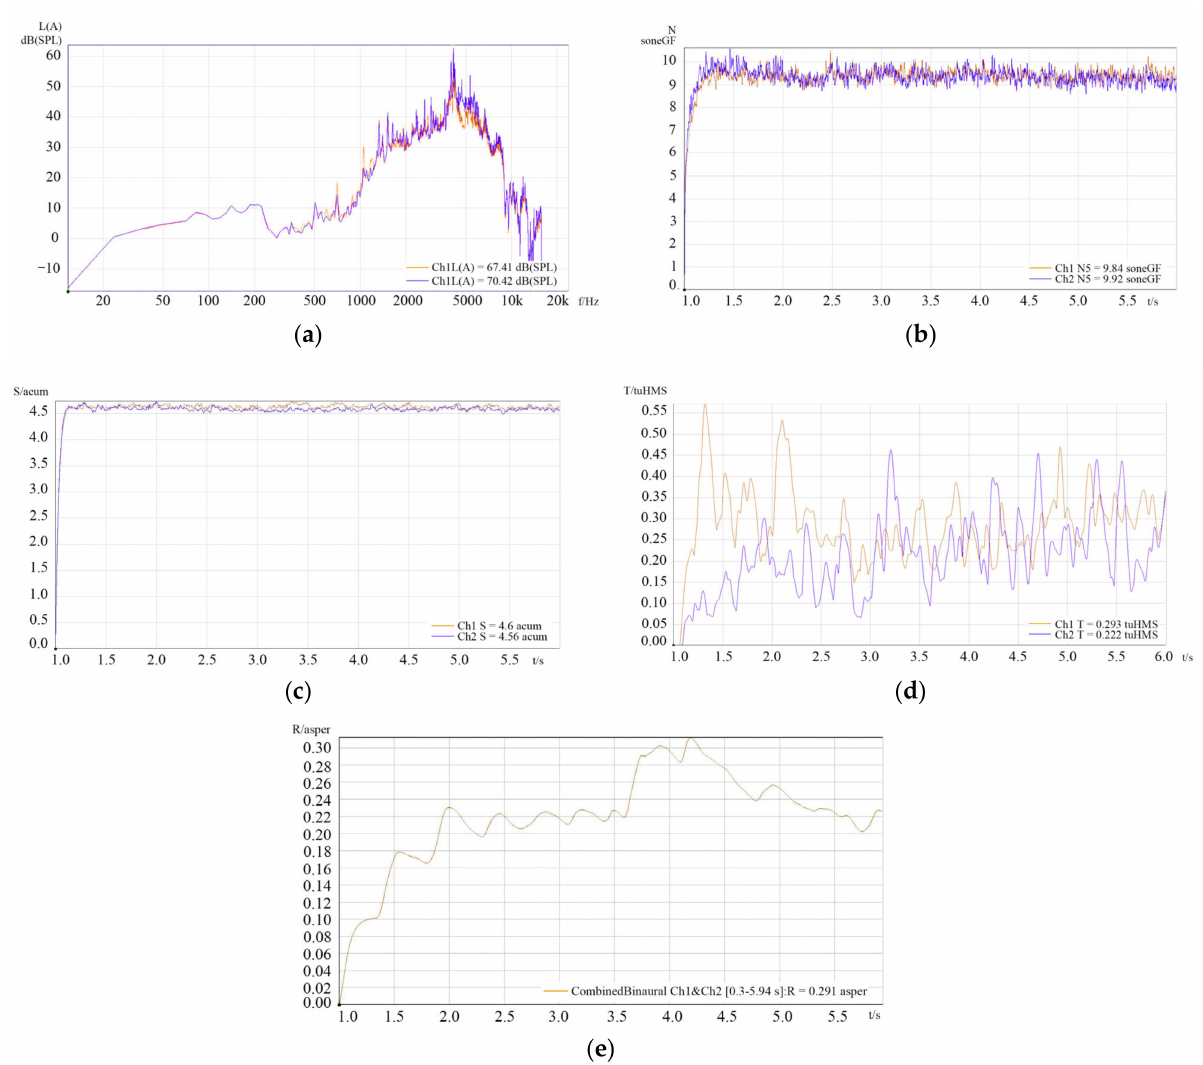
Figure 7. Diagram of the ArtemiS 13.6 for electric shaver non-contact skin-based